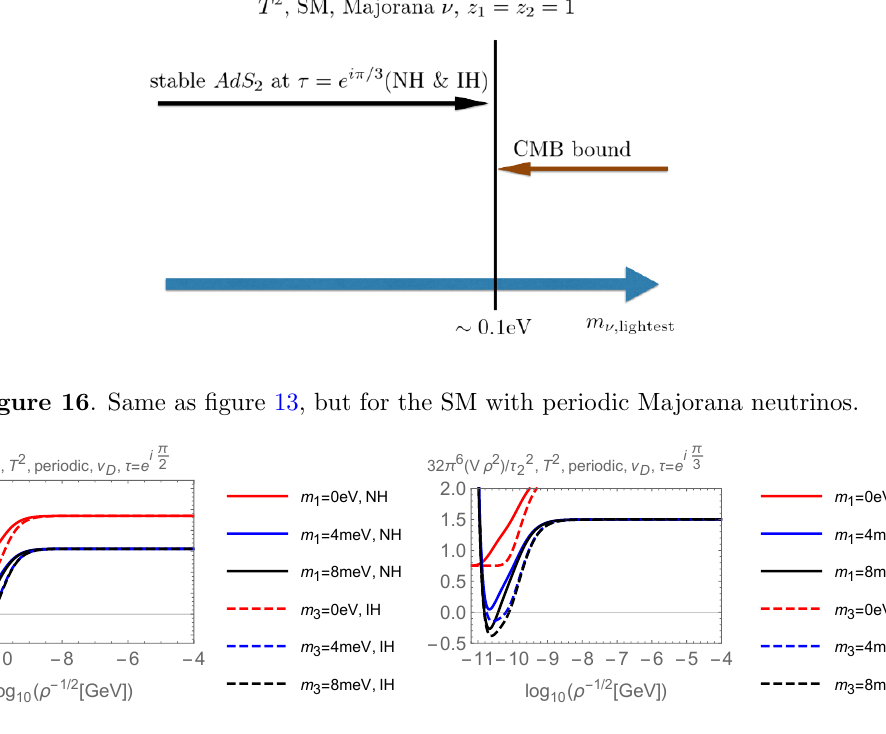
Figure 17 . Periodic Dirac neutrino with normal and inverted